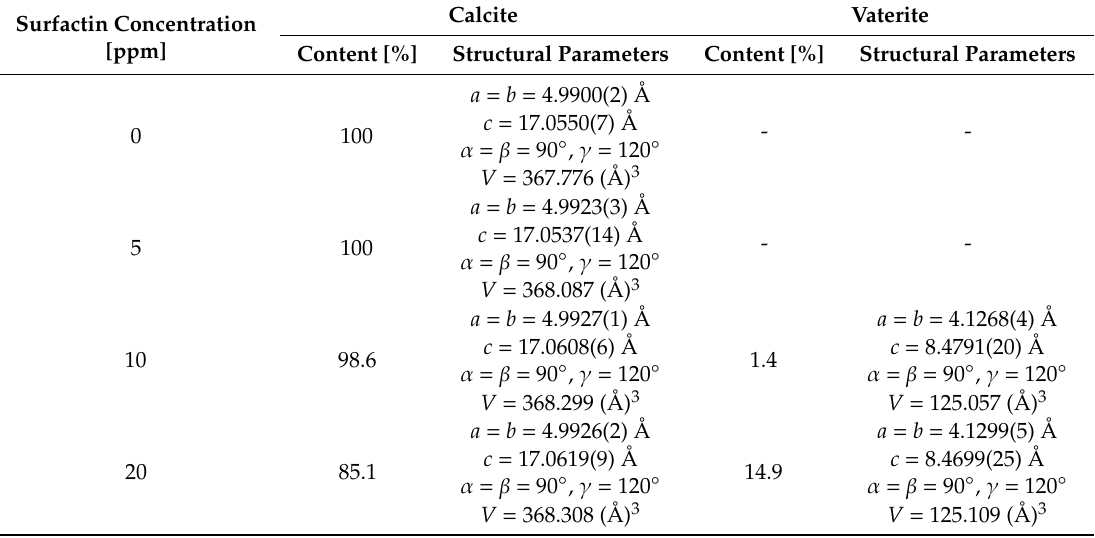
Table 2. Phase composition and the elemental cell parameters of the precipitated calcium carbonate calculated from the di ff raction patterns. (Standard deviation for calcite or vaterite content was lower than 2%. Standard deviation for calcite cell parameters a, c and V were 0.003–0.008%, 0.001 − 0.006%, 0.006 − 0.013%, respectively. Standard deviation for vaterite cell parameters a, c and V were